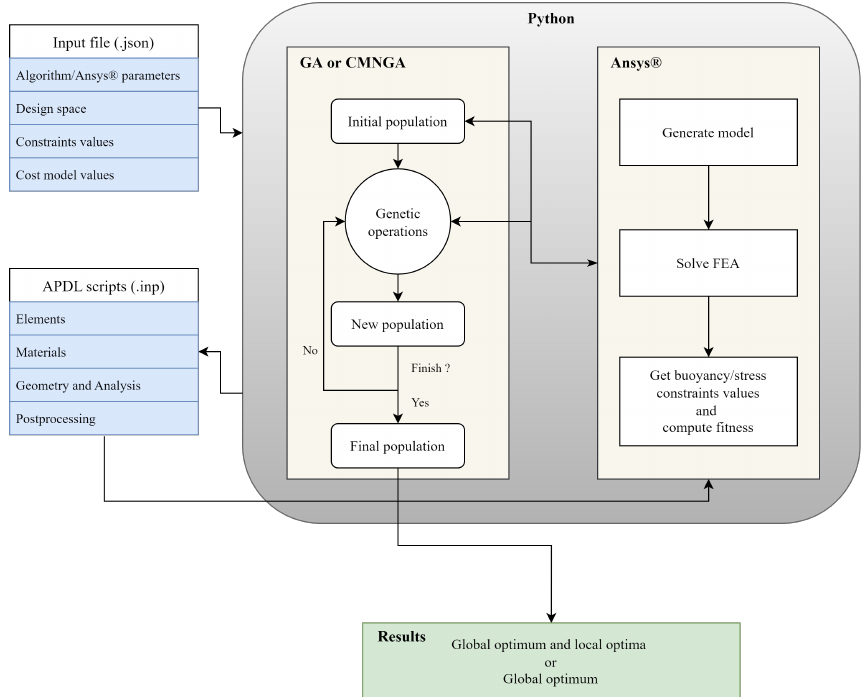
Figure 9. Framework of the Universal Buoyancy Body design optimization